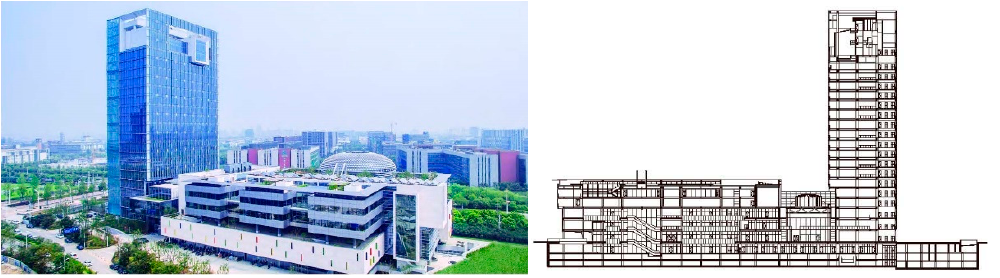
Figure 5. Zhongheng Design Center Building.